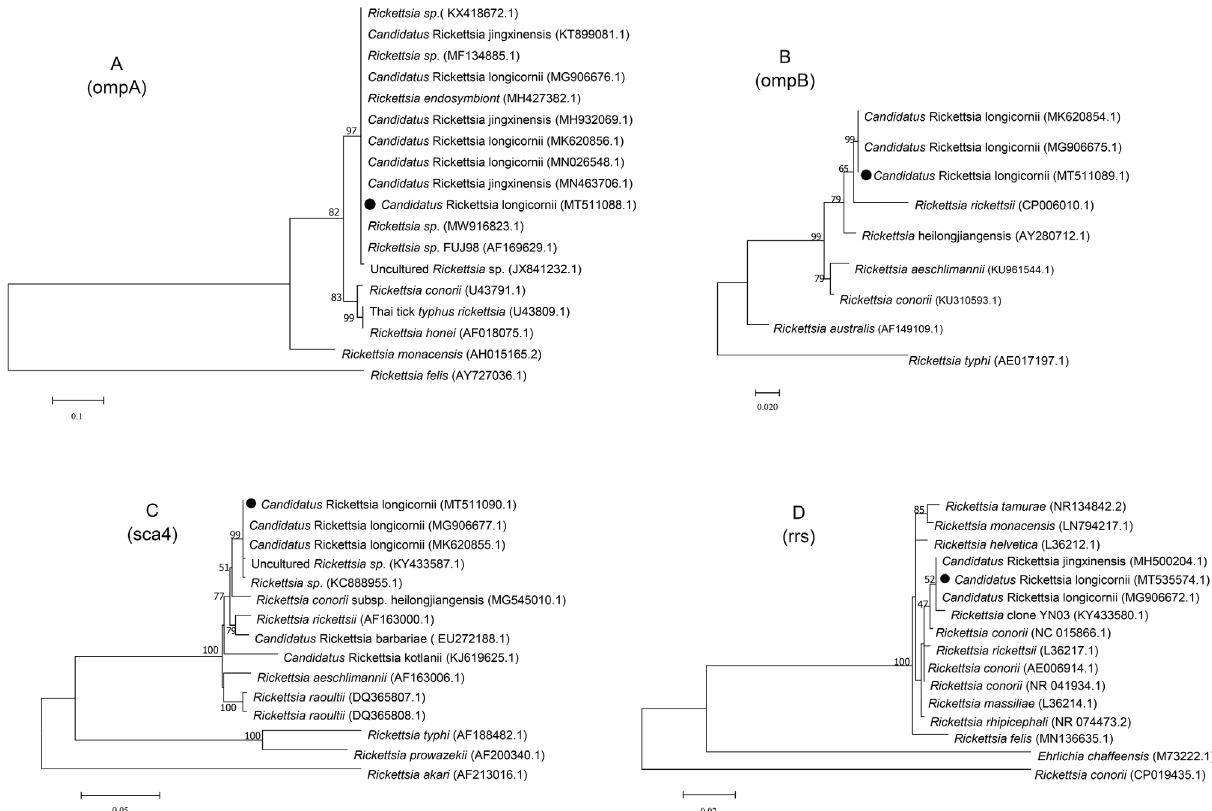
Figure 3. Phylogenetic trees based on the SFGR Candidatus Rickettsia longicornii ompA, ompB, sca4 and rrs partial sequences obtained from Haemaphysalis longicornis . The ML trees were implemented by MEGA7 with a Kimura 2-parameter model. The numbers at the nodes represent percentage of occurrence of clades in 1000 bootstrap replications of data. The gene sequences from this study are indicated by a round